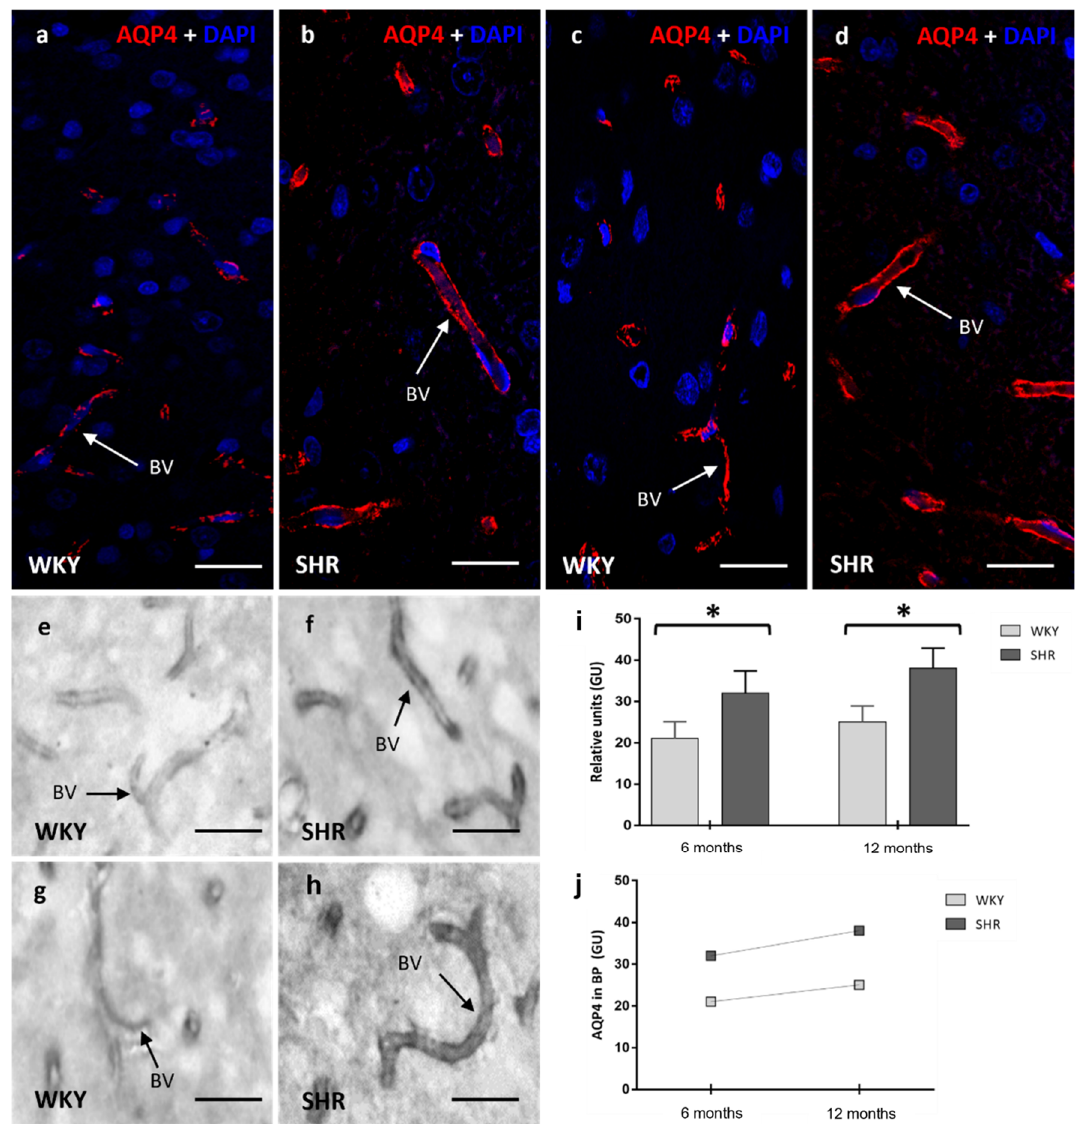
Figure 3. Confocal and optical microscopy images of AQP4 in the blood vessels of brain parenchyma of WKY and SHR rats. A significant increase of AQP4 was observed in SHR in the 6 months group when compared to WKY ( a , b , e , f ), in the 12 months group was found a more significant presence of AQP4 in the SHR ( c , d , g , h ) rats. Stain intensities in relative units for AQP4 ( i , j ) are represented as the means ± SD ( n = five animals per group). The differences between WKY and SHR were significant when applied to a One-way ANOVA test with post hoc analysis using the Tukey post hoc test (* p < 0.05). BV: blood vessel; GU: grey units. Scale bars 10 µ